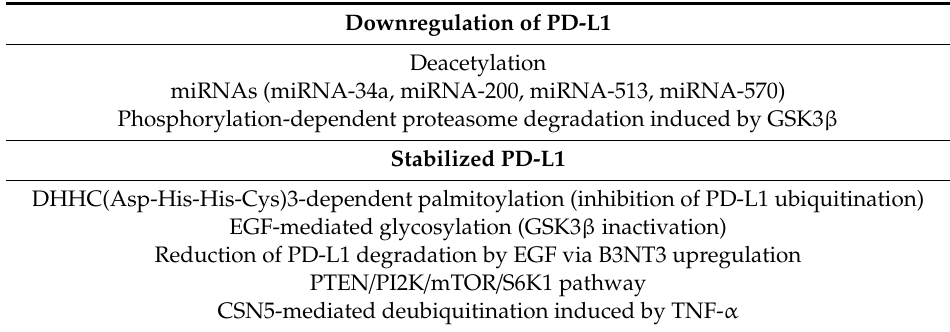
Table 1. Mechanism of post-transcriptional regulation of PD-L1 on tumor cells. Downregulation of